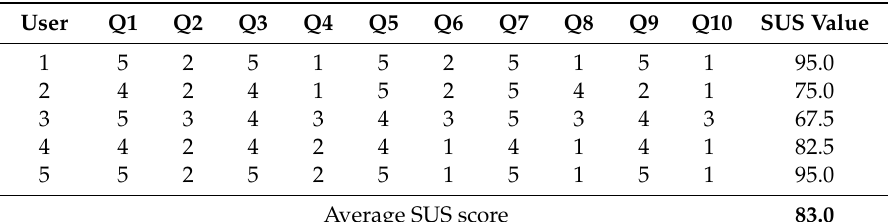
Table 2. Systems usability scale (SUS) values by